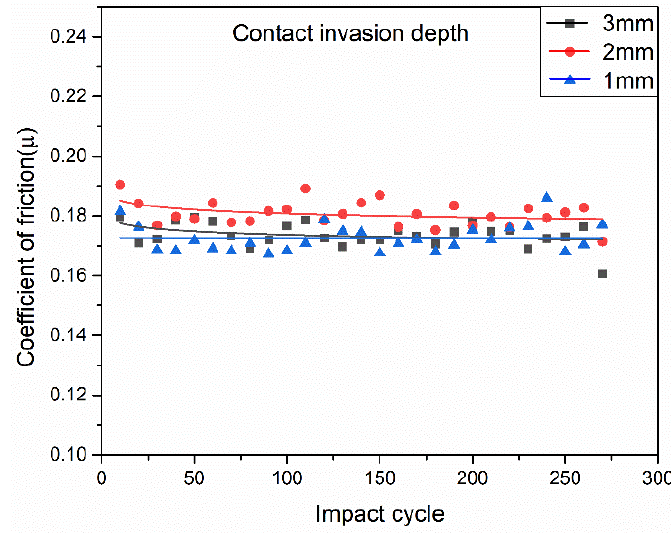
Figure 8. Change in the coefficient of friction depending on the different contact invasion depth conditions.